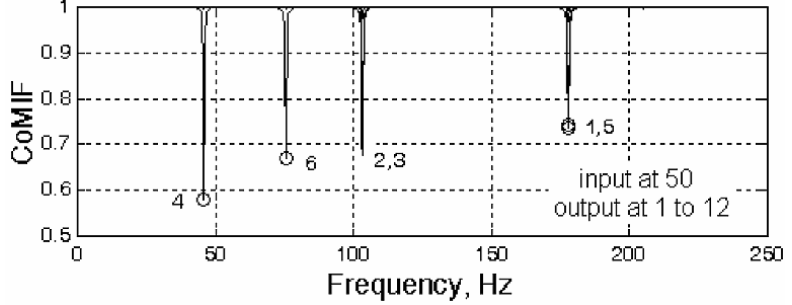
Fig. 23. CoMIF for the test